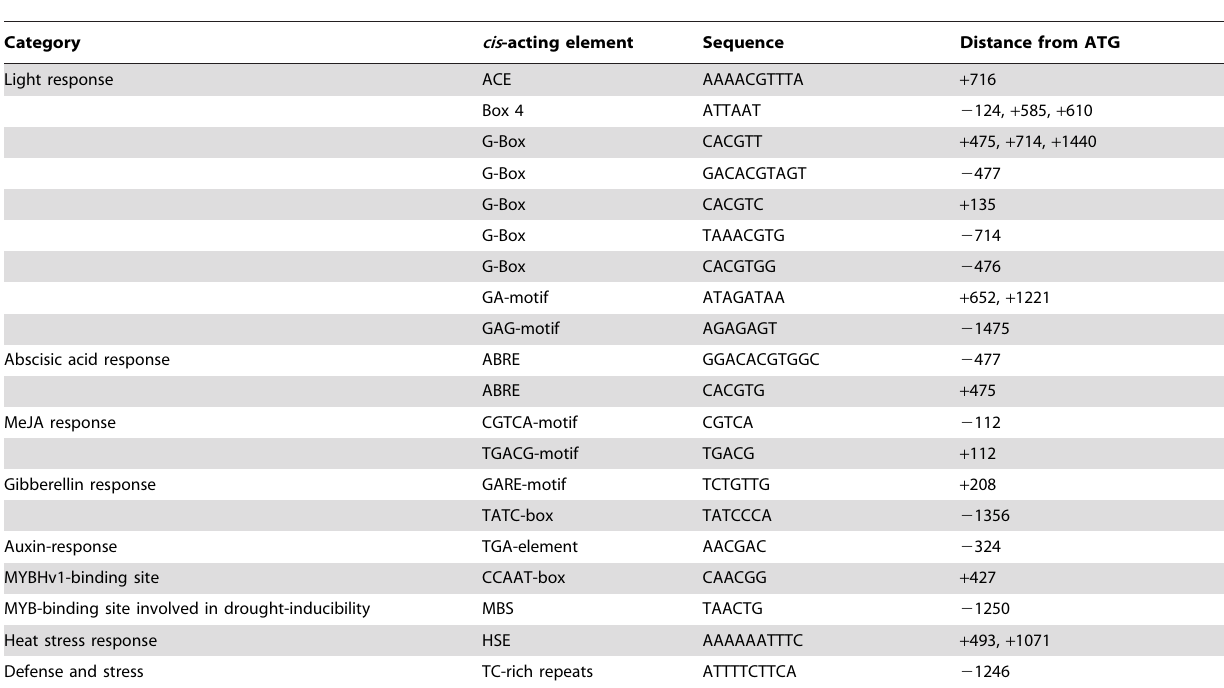
Table 1. Putative c is -elements identified in the LcMYB1 promoter.